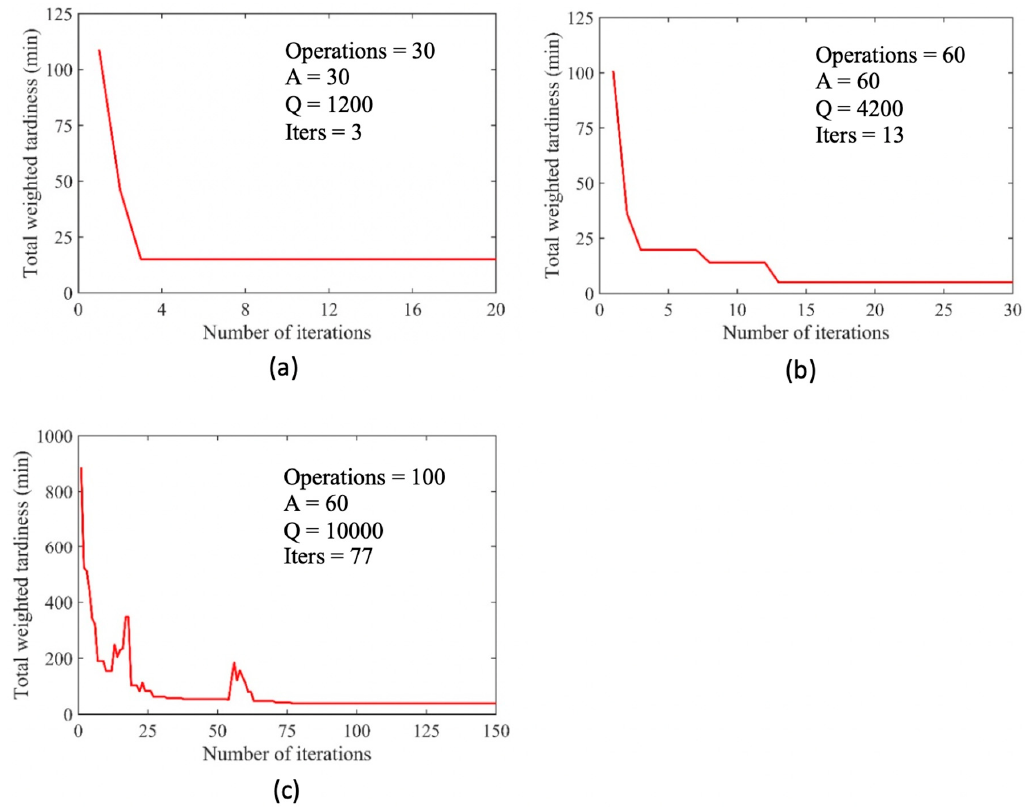
Figure 8. Tuning parameters for total weighted tardiness performance problem with varied number of operations: ( a ) 30 operations, ( b ) 60 operations and ( c ) 100 operations.